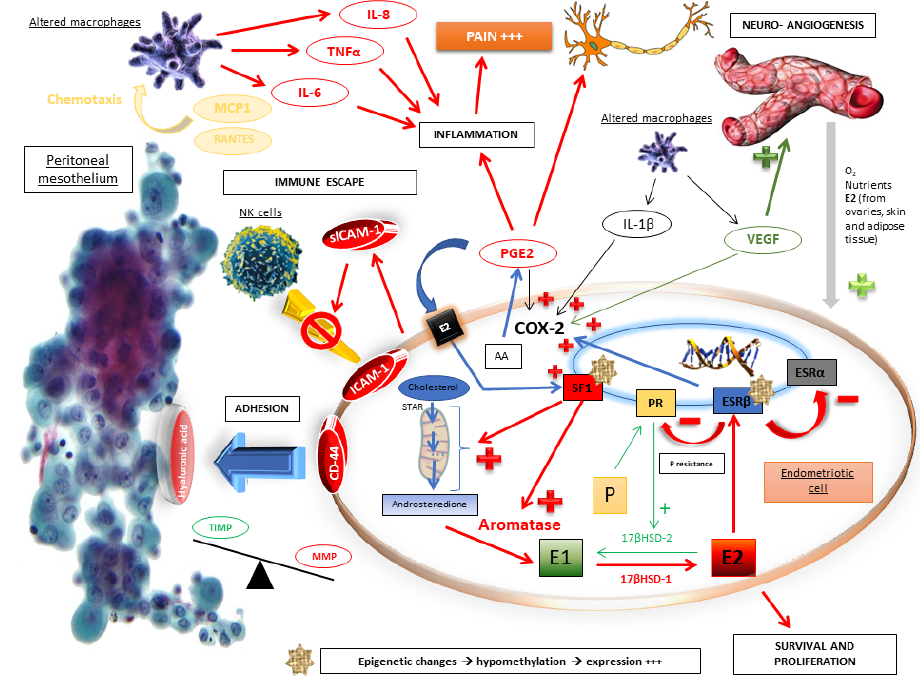
Figure 1. Molecular pathophysiological mechanisms of endometriosis [2,4,5,23].